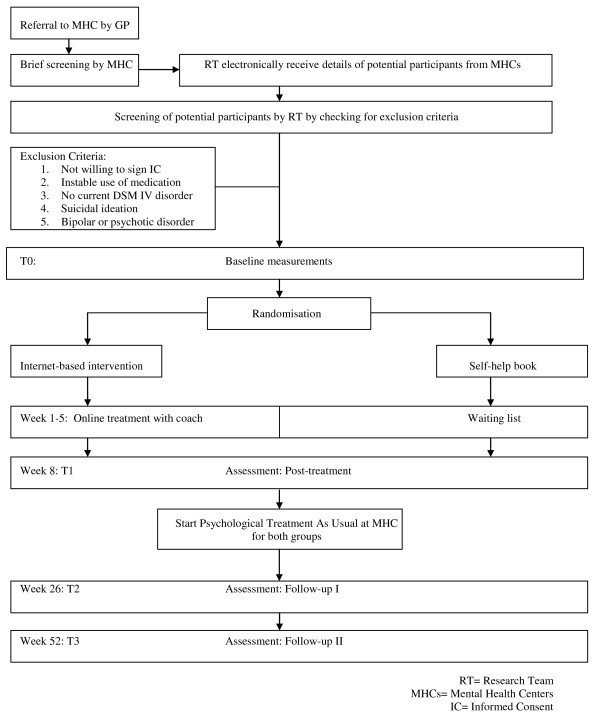
Study flow chart.